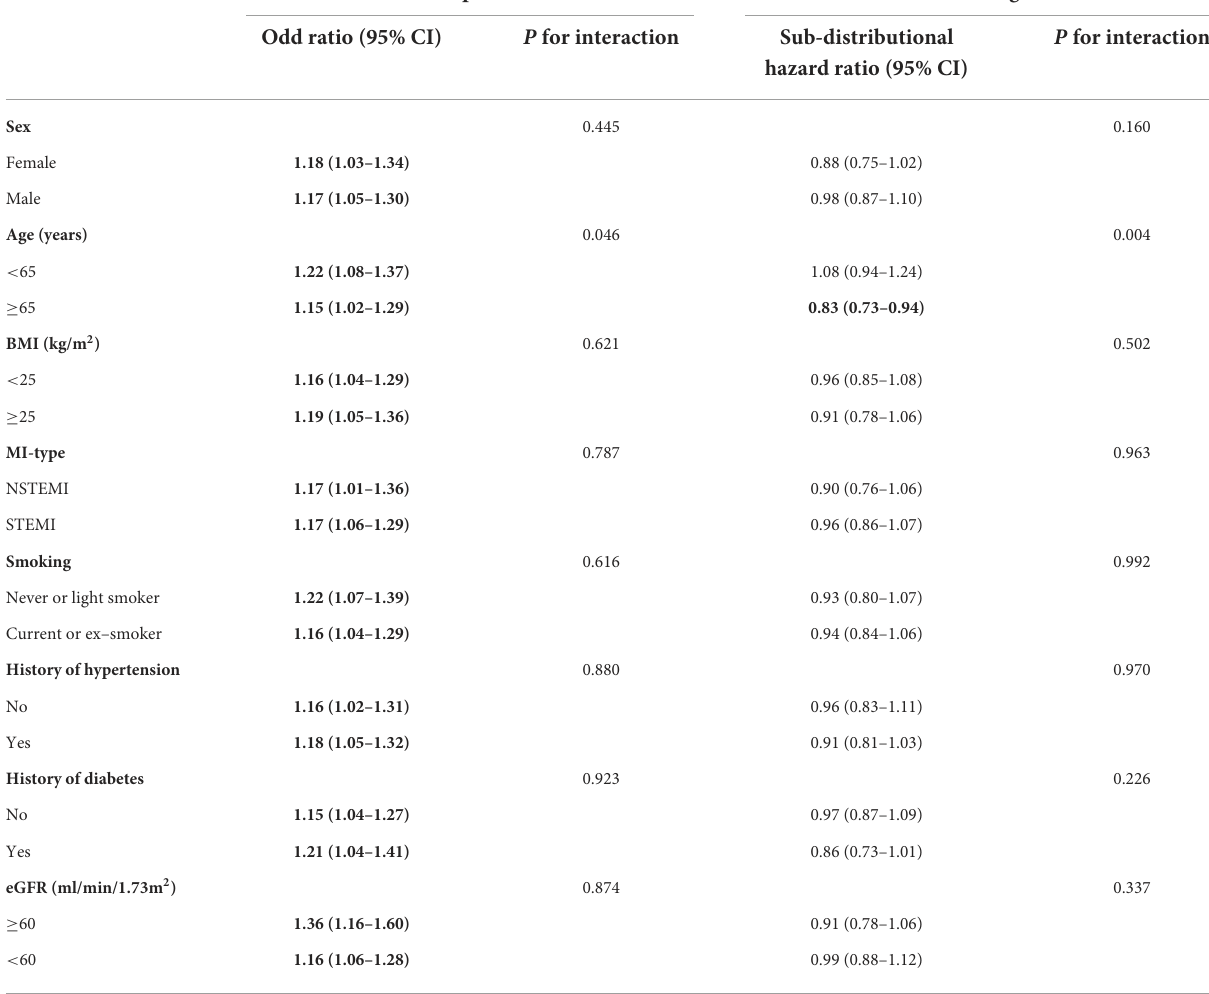
TABLE 7 Stratified analysis of in-hospital HF and post-discharge HF for corrected